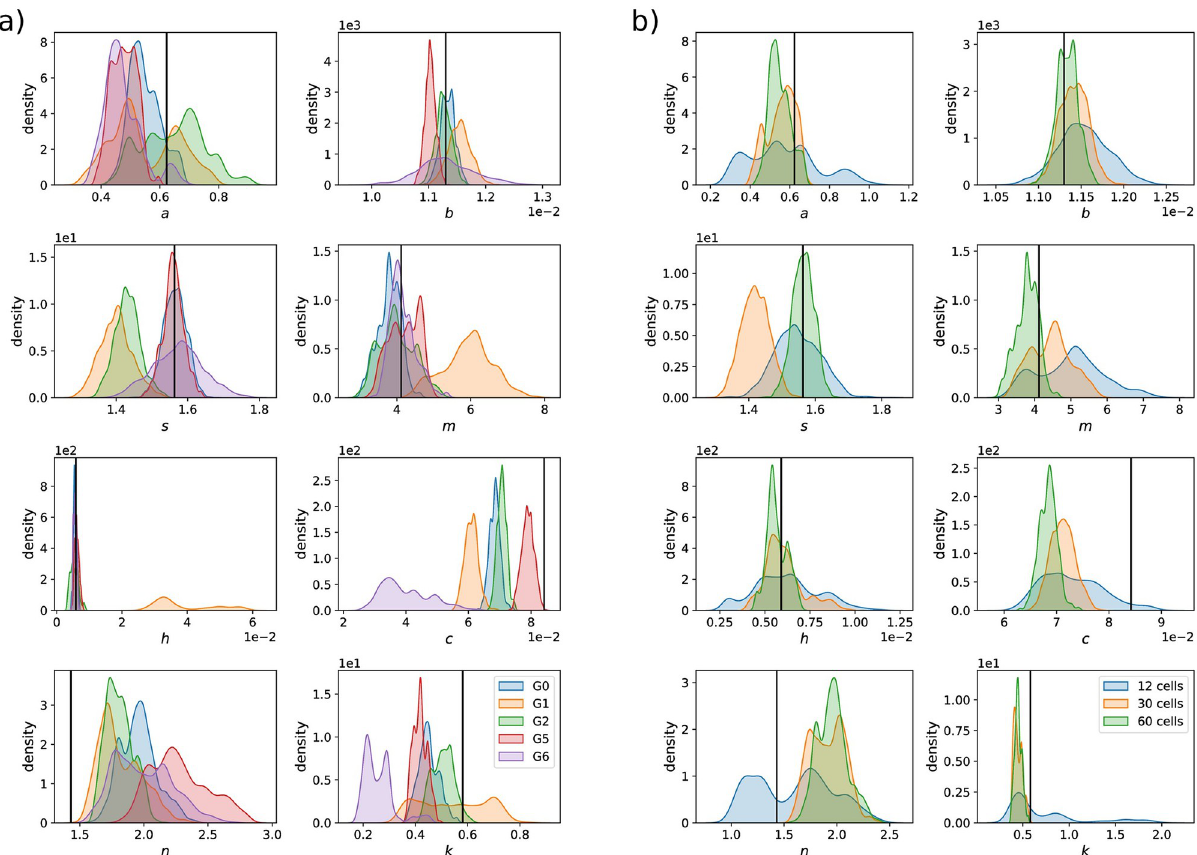
Fig 5. Inference results for the CcaS/CcaR optogenetic system. a) One-dimensional marginals of posterior distributions obtained using 60 cells, either all exposed to the same light input (G1—orange, G2—green, G5—red, G6—purple) or to diversified light inputs containing 10 cells for each of the 6 light patterns (G0—blue). The vertical black lines in each panel shows the true value of the corresponding parameter that was used to simulate the data sets. Results for data sets with 12 and 30 cells are provided in Fig D in S1 Text. Two-dimensional marginals showing correlations between model parameters are provided in Figs G-K in S1 Text. b) Posterior distributions for the mixed group, G0, for varying numbers of total cells that were used to infer parameters. Results for other groups are provided in Figs E and F in S1 Text. In all cases, posterior distributions have been obtained as histograms of values visited by the MCMC chain of 10 000 iterations, without a burn-in period of 4 000 iterations.